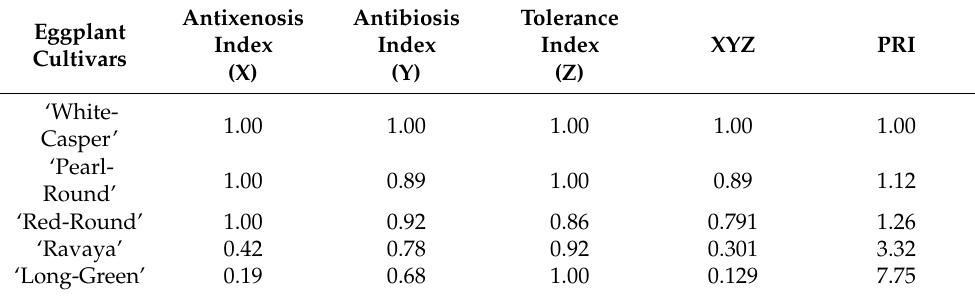
Table 5. Plant Resistance Indices (PRI) related to five eggplant cultivars infested by Myzus persicae .